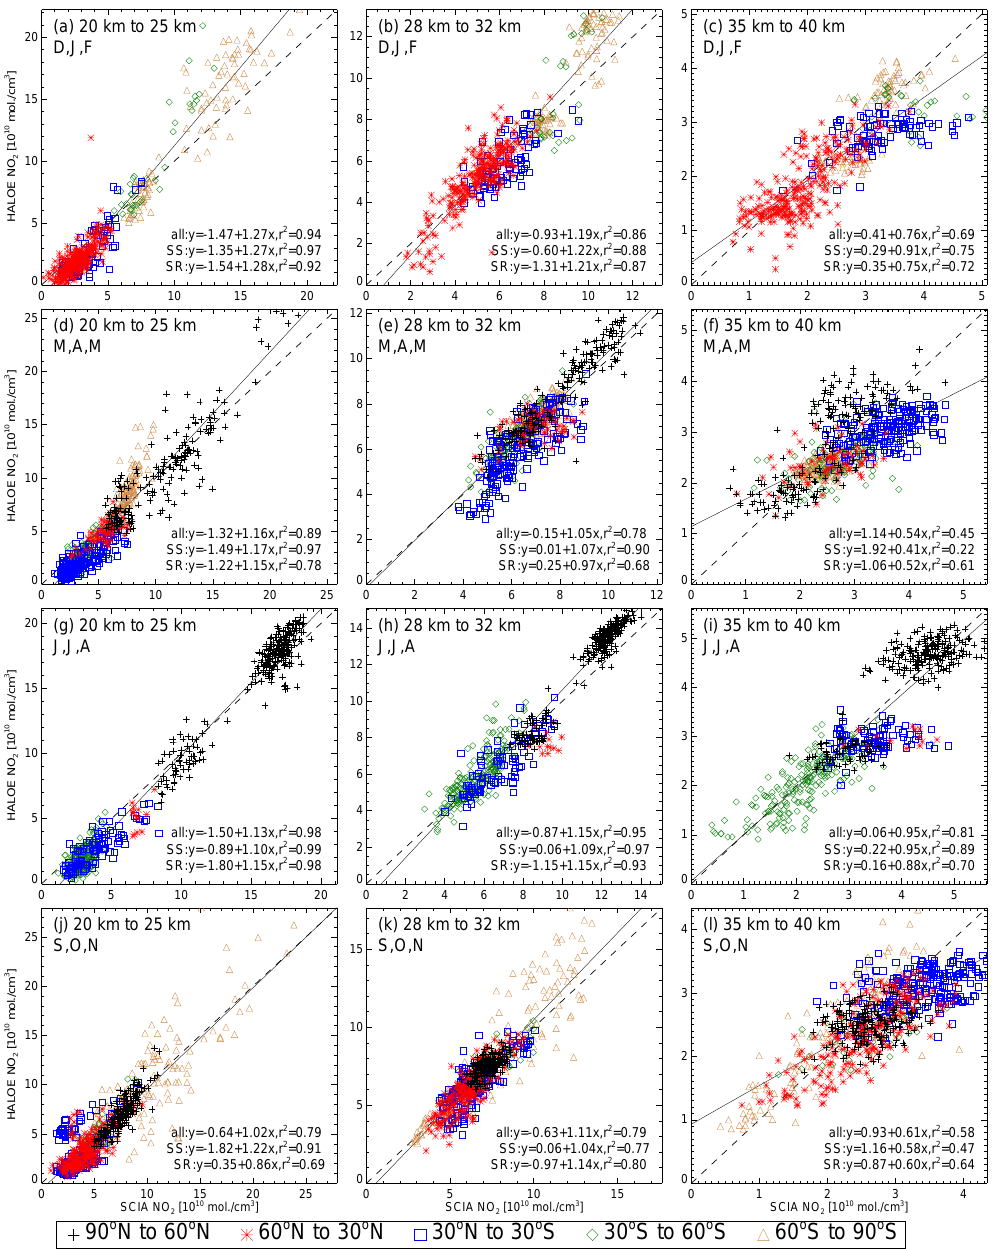
Fig. 11. Same as Fig. 8, but for HALOE data. 2592 collocation pairs are shown (913 for HALOE sunset and 1679 for sunrise).